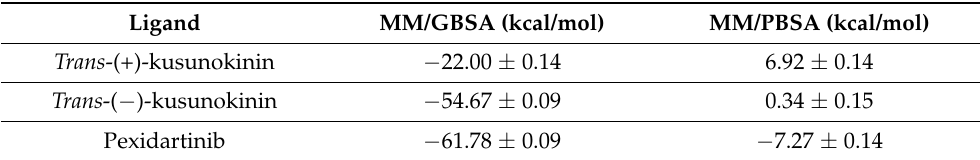
22.00 0.14 6.92 − ± 54.67 0.09 0.34 − ± 61.78 0.09 − ±